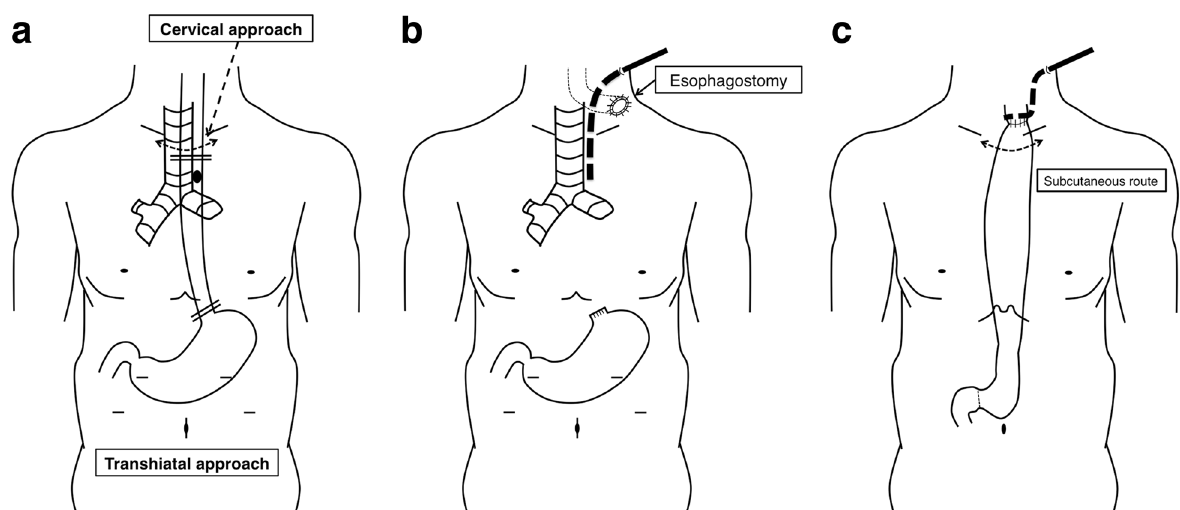
Fig. 5 Schematic illustrations of the two-stage operation. a Subtotal esophagectomy was performed in the first stage operation with the combination of transcervical and transhiatal approaches. Dashed arrow, cervical skin incision; double lines, oral and anal margins of the esophagectomy; black dot, the location of the esophageal perforation. b Status after the first stage operation. Cervical esophagostomy was placed in the left side of the patient ’ s neck and a 19-Fr drainage tube (dotted thick line) was placed via the left side of the patient ’ s neck into the upper mediastinum. c Status after the second stage operation. Gastric conduit was lifted via a subcutaneous route, and an esophago-gastric anastomosis was performed. A 19-Fr drainage tube (dotted thick line) was placed behind the anastomosis via the left side of the patient ’ s